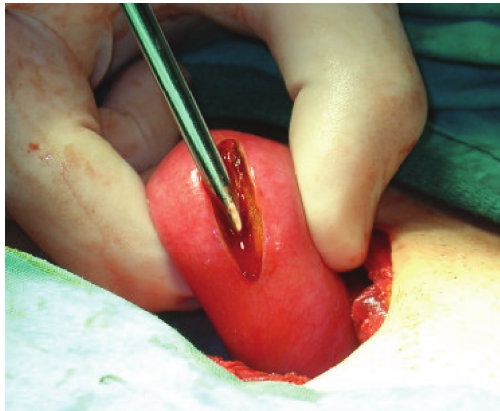
Figure 4: Uterine cavity catheterized with a hysterometer which is pushed downward until neovaginal space was accessed.